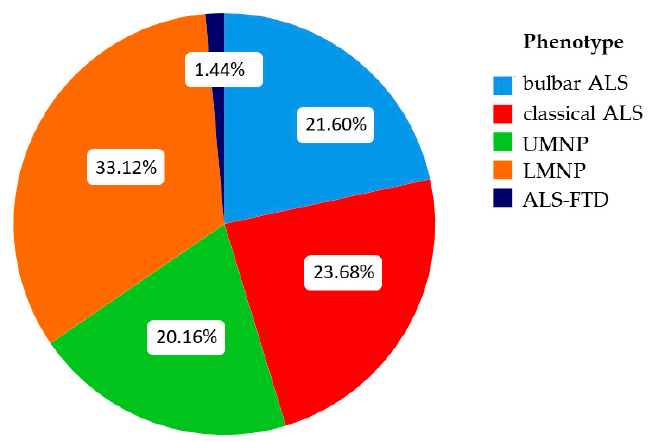
Figure 1. Distribution of clinical phenotypes. UMNP = upper motor neuron predominant; LMNP = lower motor neuron predominant; ALS-FTD = ALS with frontotemporal dementia. Overall survival was analyzed from symptom onset until death of any reason. Survival